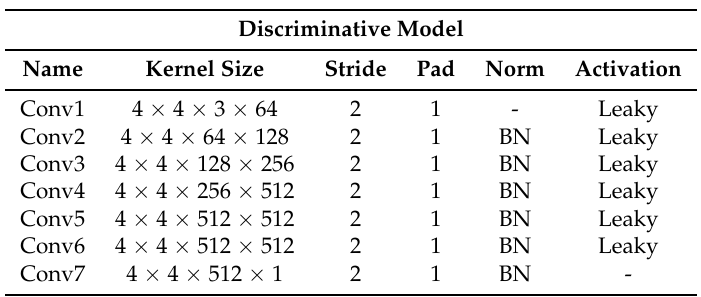
Table 2. Discriminative model network architectures. Conv means Convolutional layer; BN means Batch Normalization; Leaky means leaky rectified linear